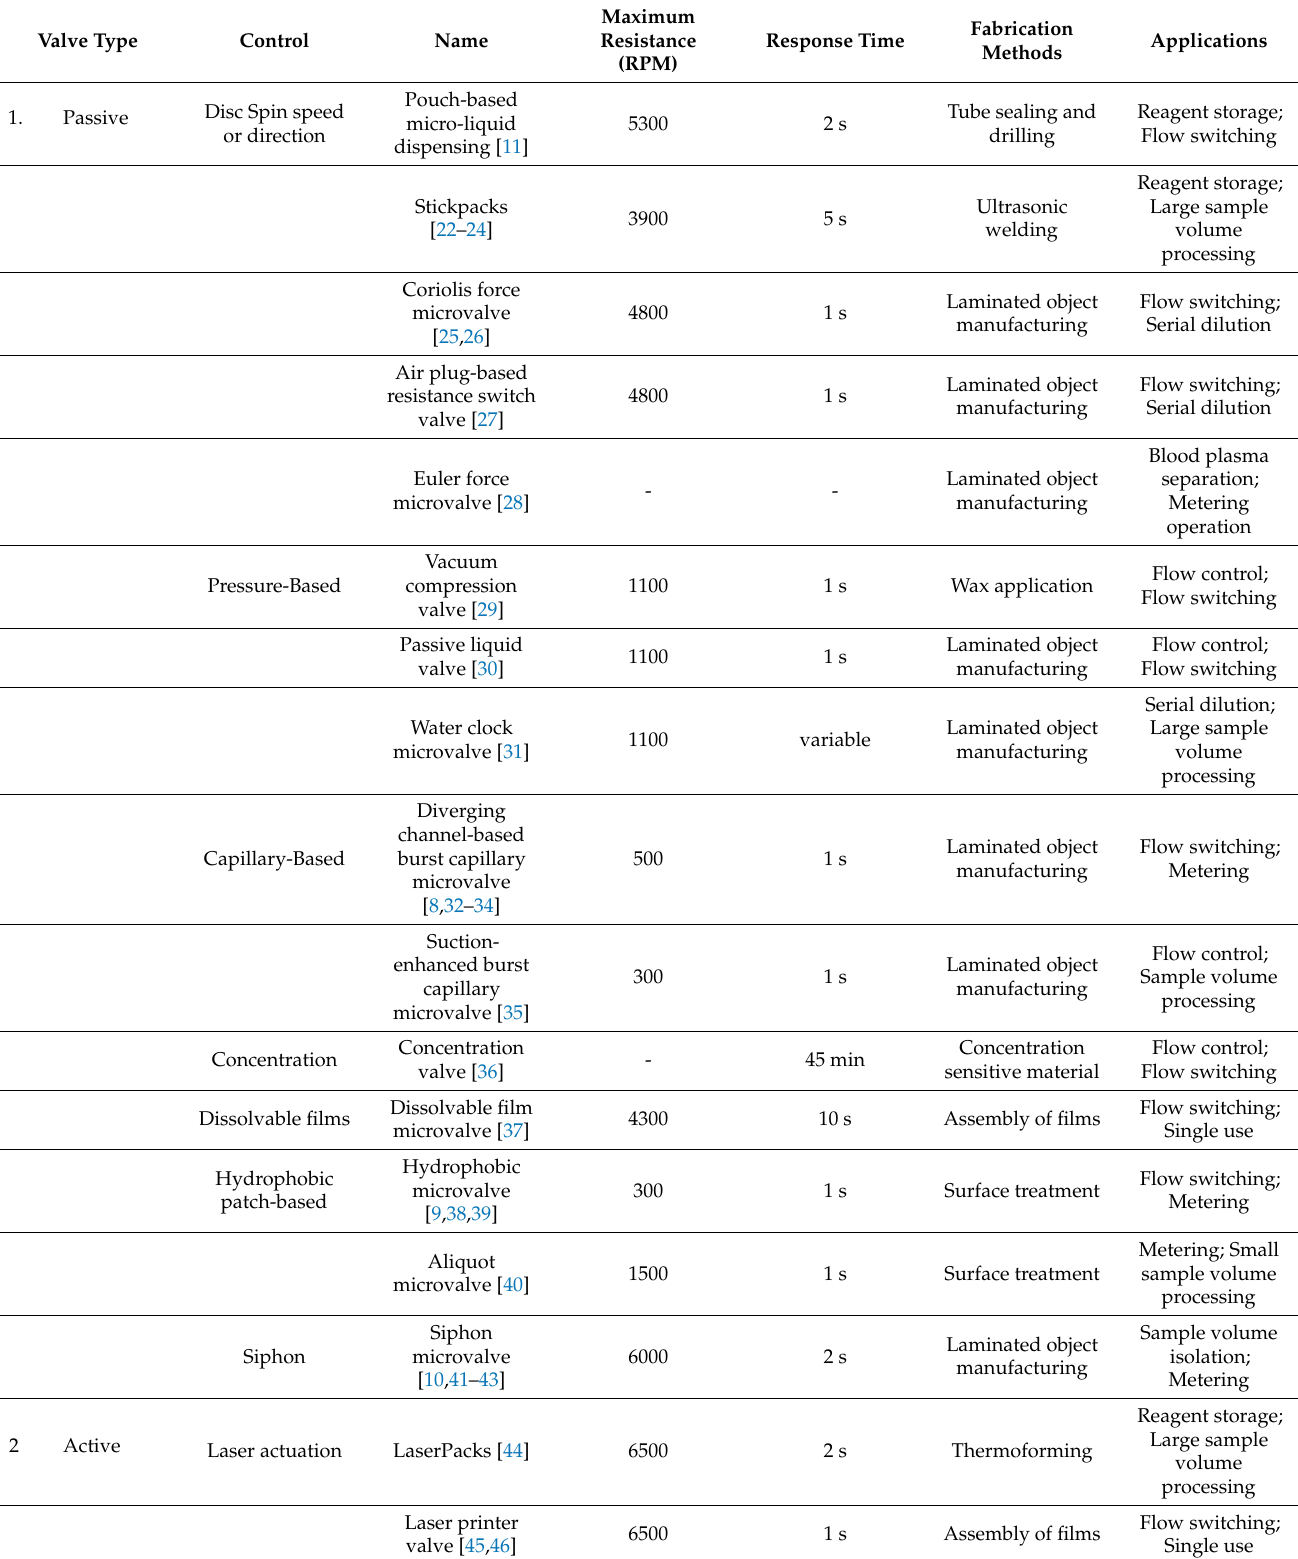
Table 1. Classification of valves and their compatibility with CD fluidics, costs, and response